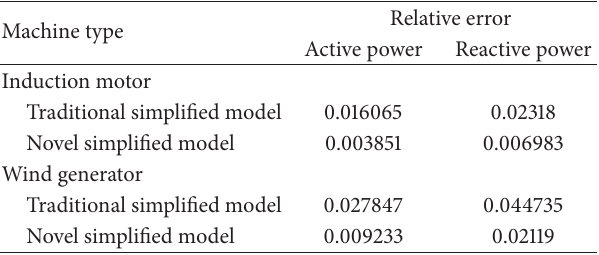
Table 4: Error analysis of different